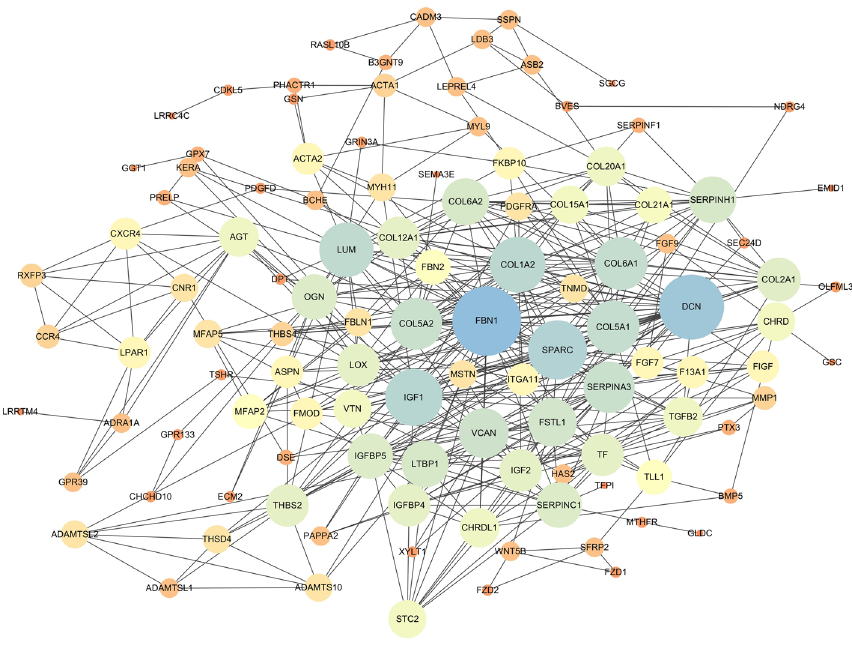
Figure 8. Protein–protein interaction network for the DEGs identified in this study. Nodes represent proteins, and edges represent interaction between proteins. The size of a node is proportional to its degree (degree is defined as the number of proteins that interact with the node). The color of a node is used to distinguish nodes with different degrees.